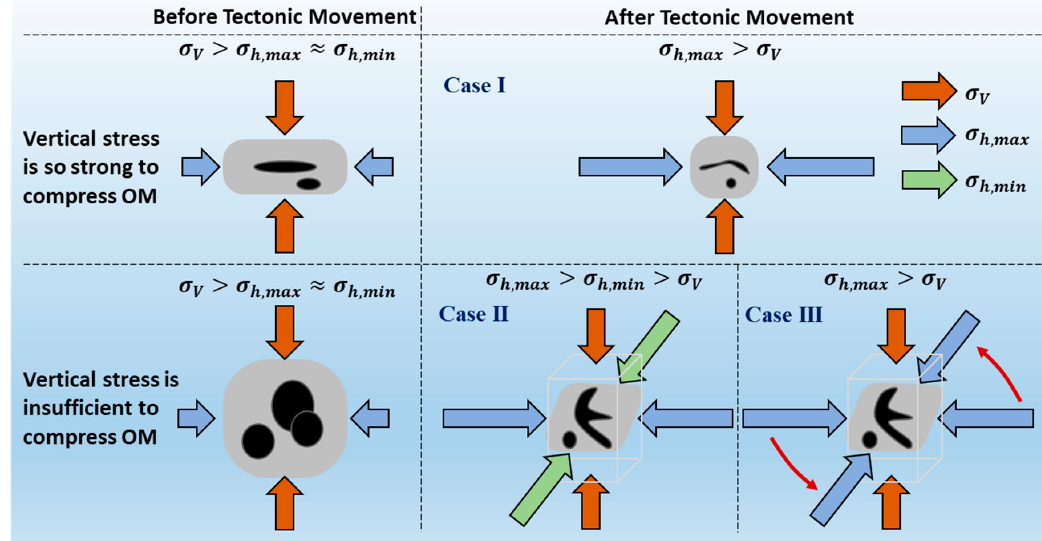
Figure 14. The generalized deformation process and the associated stress condition of OM V during tectonic movement. The orange arrow indicates rotation of the improved horizontal principle stress due to tectonic movements.